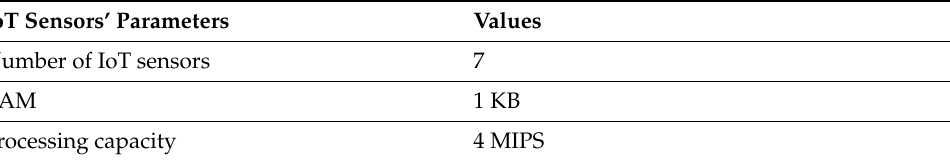
Table 4. Smart home IoT sensors’